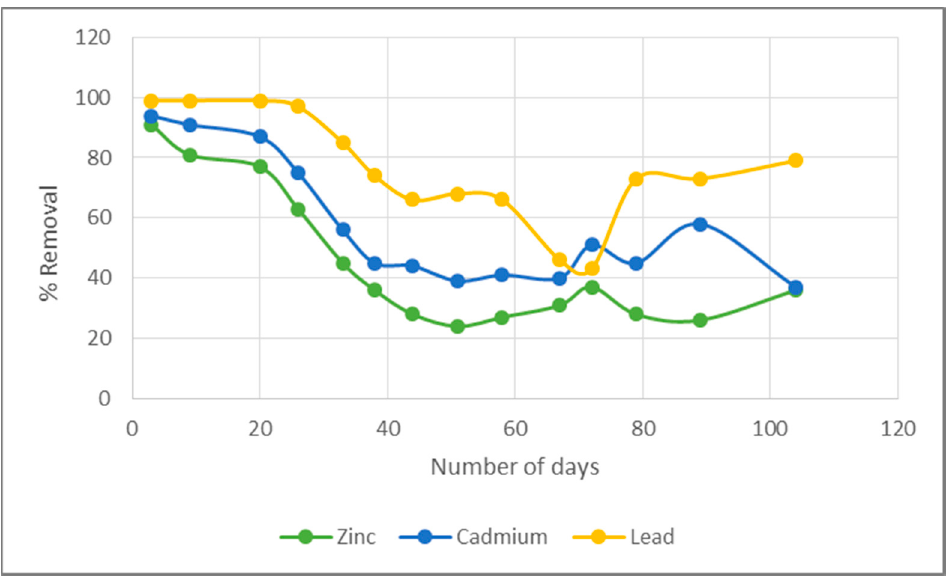
Figure 4. Graph showing results from the field-scale trial. Removal efficiency of the compressed pellets for adsorbing filtered zinc, cadmium and lead over a 3 month period at Bridford Barytes mine. Data taken from Comber (2015) [20].